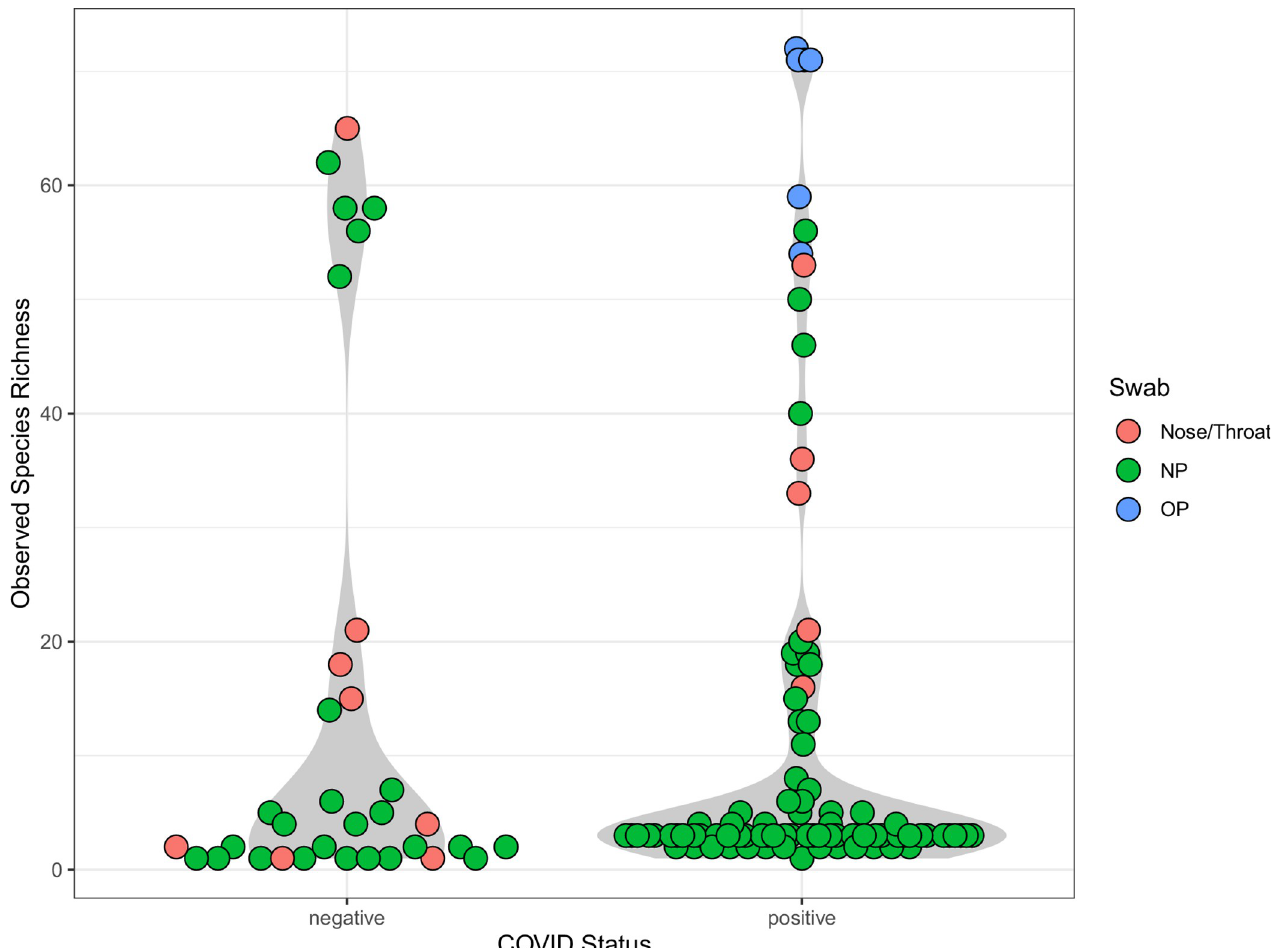
Fig 2. Observed species richness in SARS-CoV-2 positive vs negative samples detected by the LLMDA. Samples with no species detected are not included. The samples were coded by color based on their types: nose/throat swabs are shown in red circles; NP swabs are shown in green circles; OP swabs are shown in blue